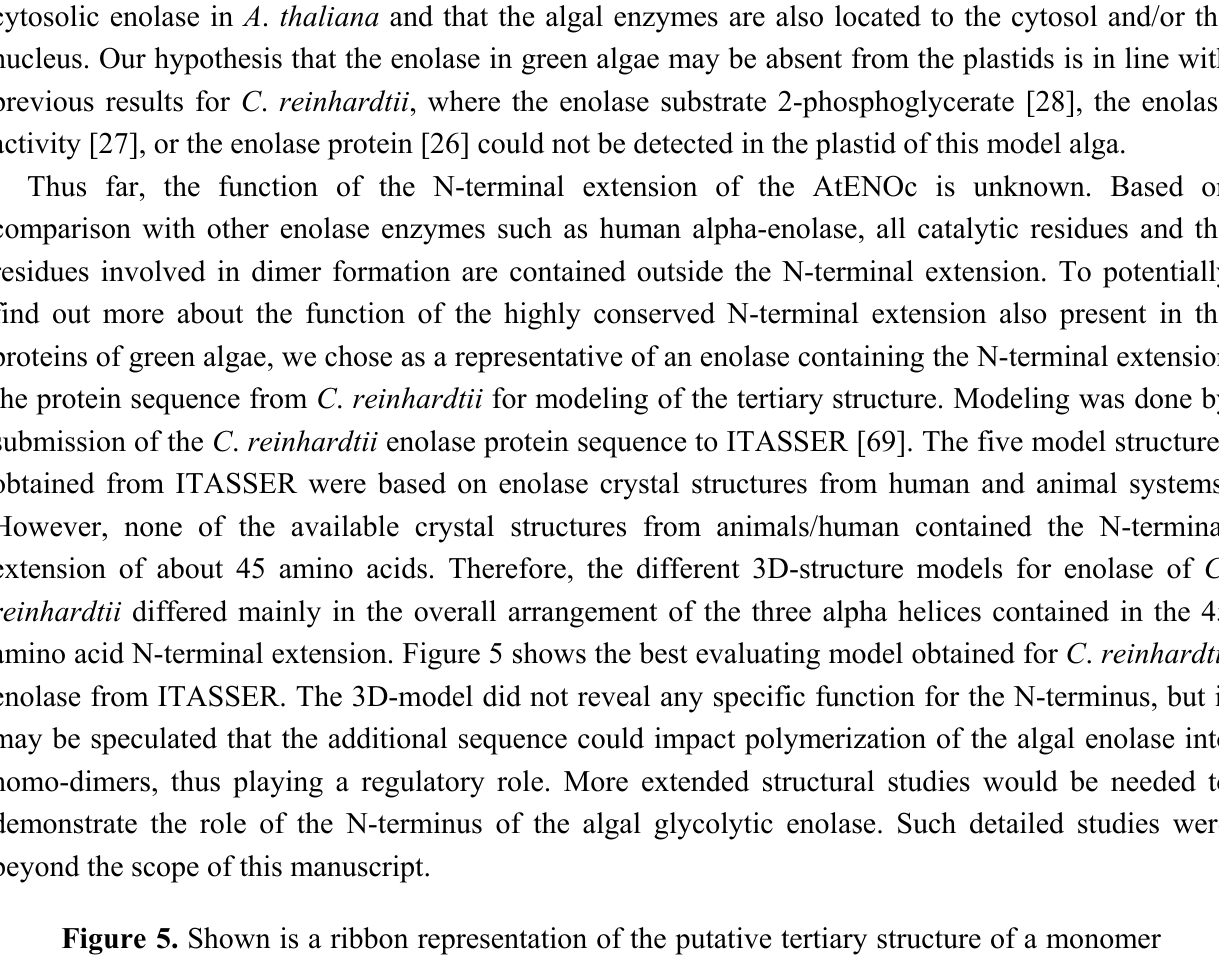
of the N-terminally extended enolase of the green alga C . reinhardtii . The N-terminal β -sheet with 3 strands and the C-terminal β -sheet with enolase active site are shown in dark grey. The location of the potential alternative translation start site Met136 is shown in